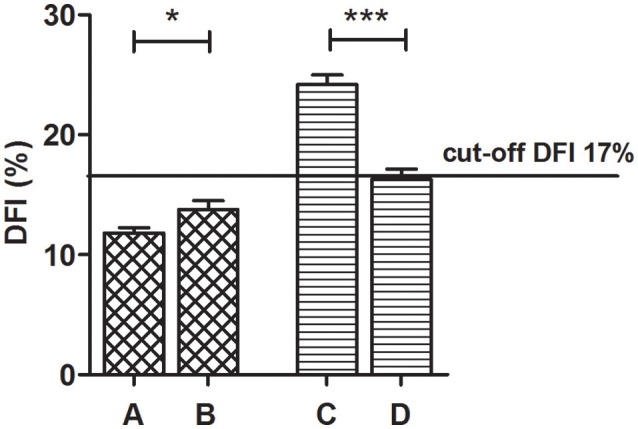
Comparison of the baseline and the post-treatment DFI mean values, by dividing patients in accordance to the median DFI baseline value of 17% (DFI < 17% – 48 patients and DFI ≥ 17% – 55 patients) (Wilcoxon signed-rank test). (A) Baseline DFI < 17%, (B) Post treatment DFI < 17%, (C) Baseline DFI ≥ 17%, (D) Post treatment DFI ≥ 17%. *P < 0.05 ***P < 0.001.